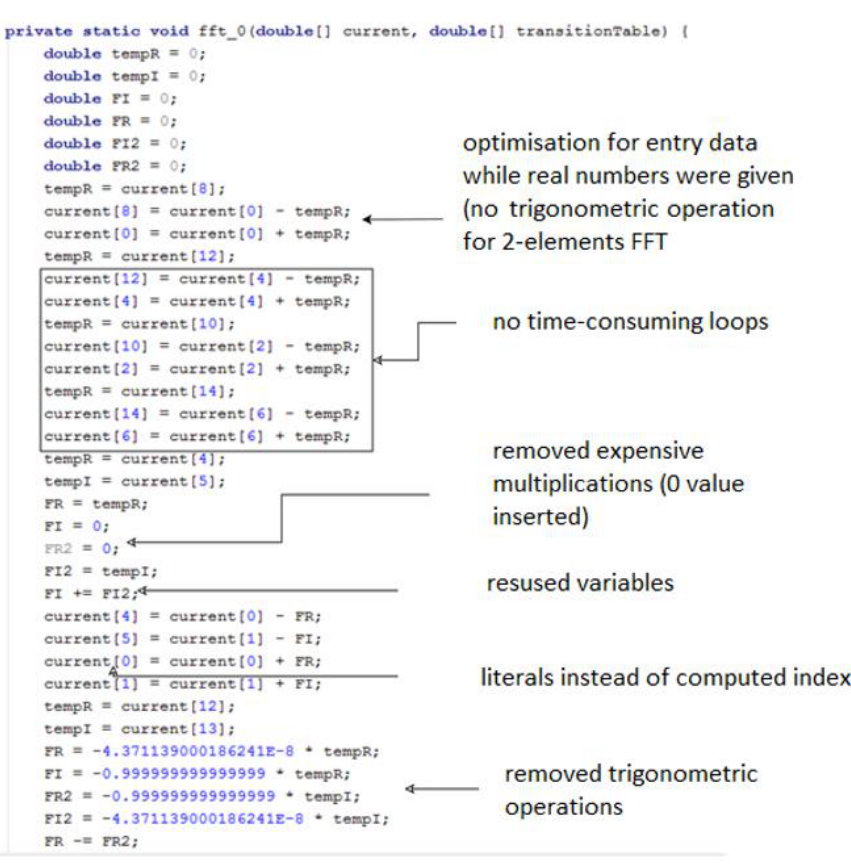
Figure 5. Profit from the application of the metaprogramming technique (generated code of the Short Time Fourier Transform